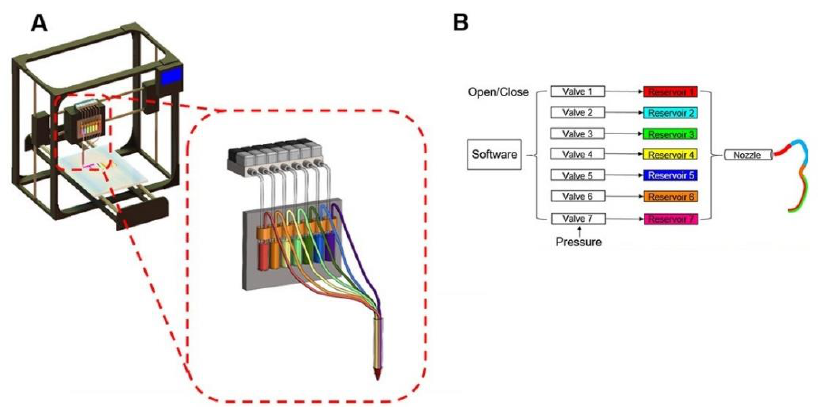
Figure 6. An example of a bioprinting setup (reprinted with permission from Liu et al.; copyright (2016) [99]). The design of a “digitally tunable continuous multi-material extrusion bioprinter” consisting of a “seven-channel printhead connected to reservoirs that are individually actuated